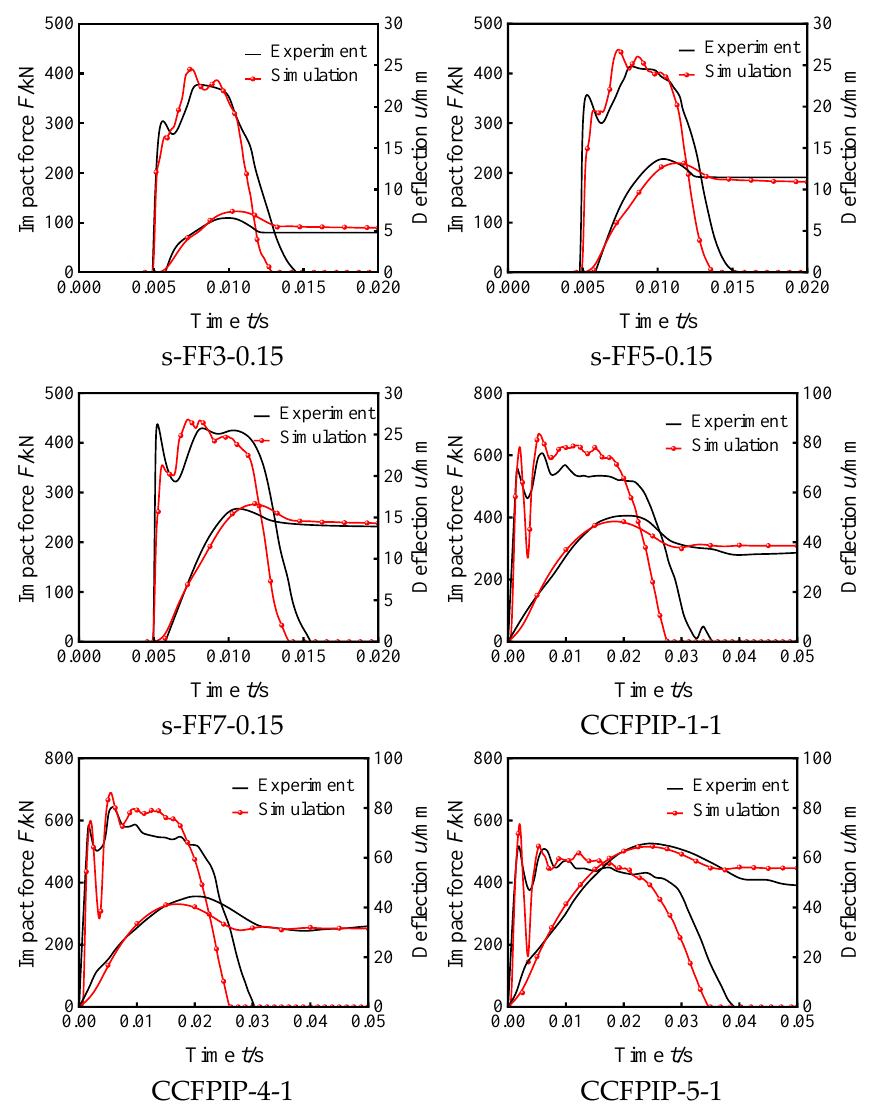
Figure 6. Comparison of numerical and test curves. Table 4. Comparison of numerical and test results.